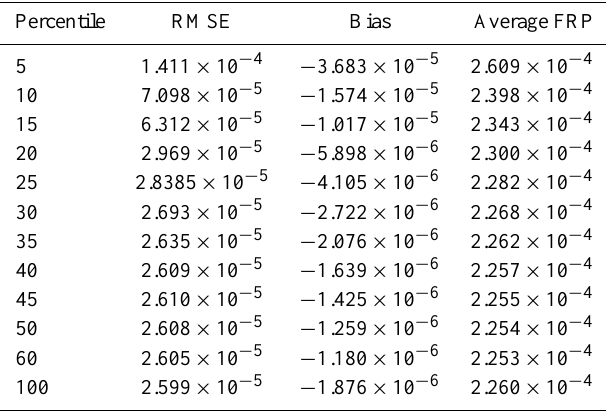
Table 2. RMSE and bias of mean global FRP in mWm − 2 for the year 2012 for Aqua-GFAS as a function of the percentile of gridded FRP above which linear regression is applied instead of non-linear regression.